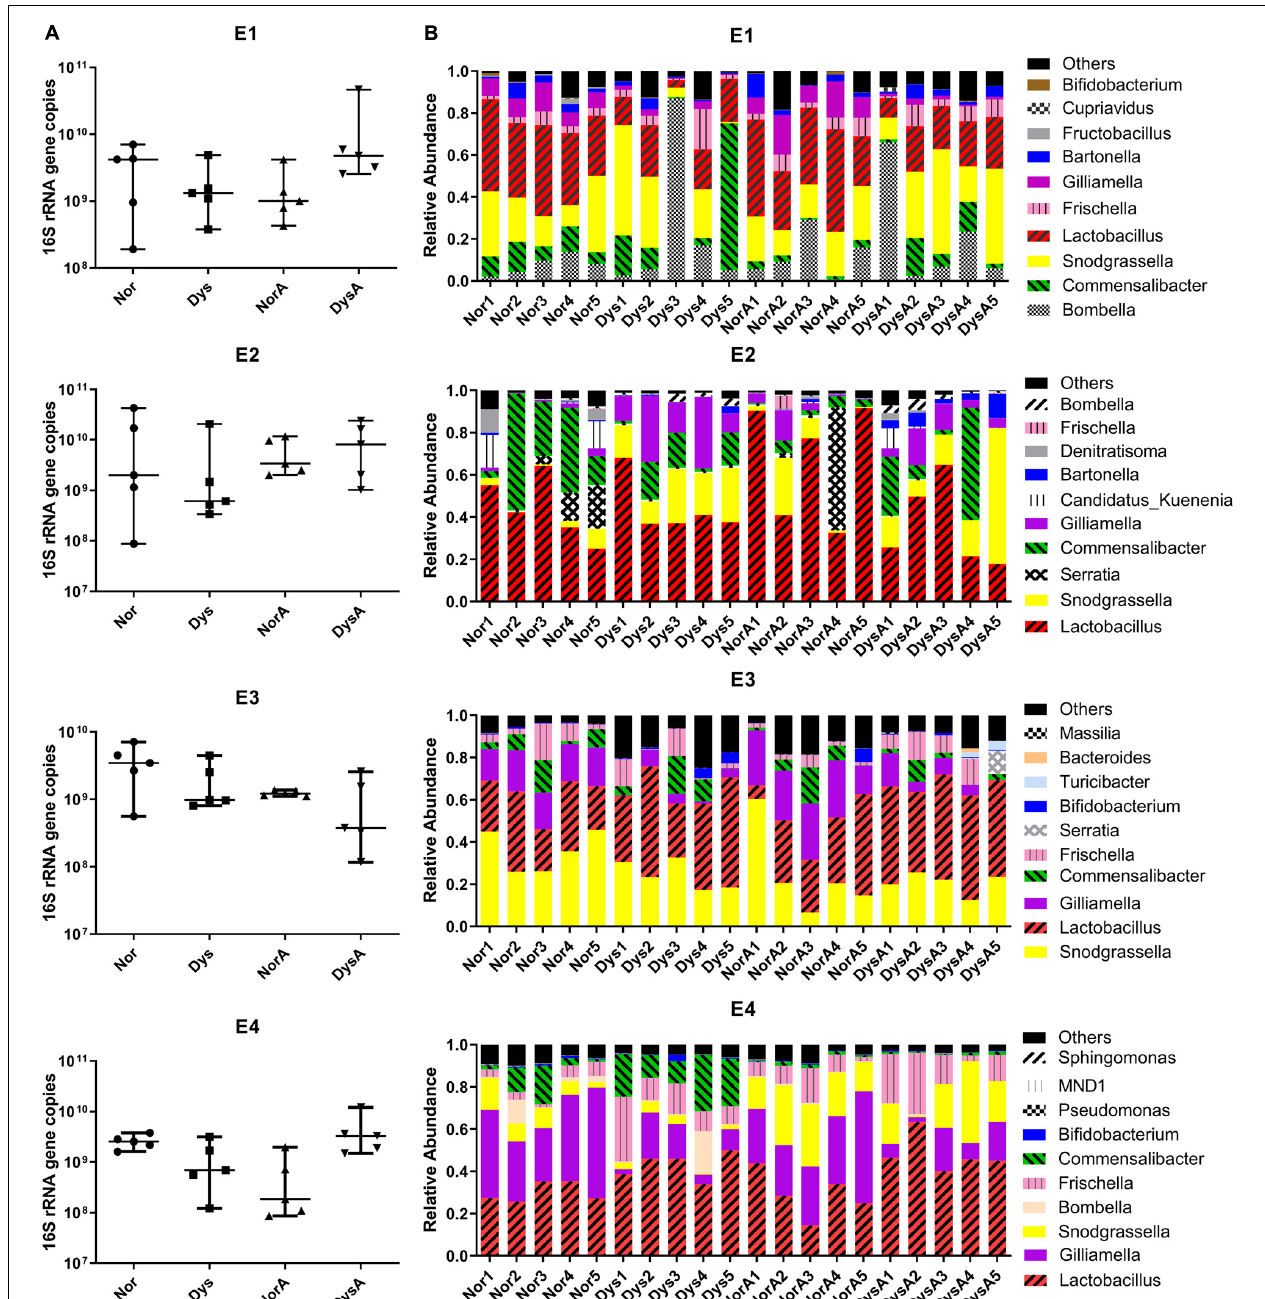
FIGURE 3 | Size and Composition of gut bacteria of Nor, Dys, NorA, and DysA honey bee workers. (A) The absolute abundance of gut bacteria of Nor, Dys, NorA and DysA workers ( n = 5), total bacterial 16S rRNA gene copies were estimated by qPCR. (B) Stacked column graph showing the relative abundance of bacterial species in Nor, Dys, NorA, and DysA workers. Nor, workers colonized with normal gut community, Dys, workers colonized with dysbiotic gut community, NorA, workers colonized with normal gut community and treated with 10 µ g/mL tetracycline, DysA, workers colonized with dysbiotic gut community and treated with 10 µ g/mL